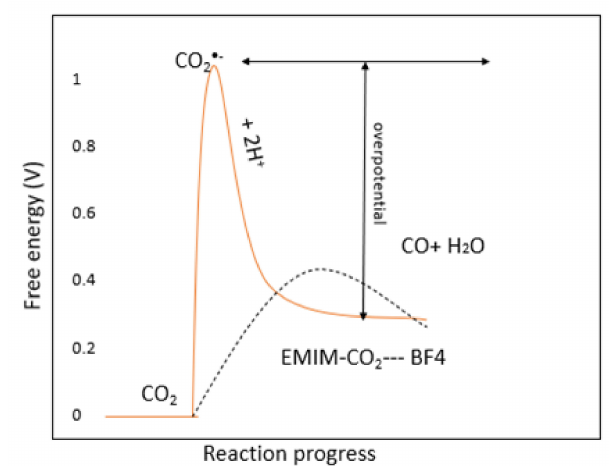
Figure 9. A schematic of how the free energy of the system changes during the reaction of CO 2 + 2H + + 2e − → CO + H 2 O in water or acetonitrile (solid line) or in the IL [Emim][BF 4 ] (dashed line) [45]. Sun et al. and Ramesha [85] studied the selectivity of the reaction towards CO, where they used Pb as the cathode and [Emim][Tf 2 N] as the electrolyte, and they found that the production of CO can be attributed to the interaction between CO 2 and the cation [Emim] + monolayer at the cathode surface. The results indicated that the CO 2 •− and [Emim] + adsorbed on the cathode surface could direct the CO 2 •− reaction toward forming CO rather than oxalate. They concluded that [Emim] + stabilized the CO 2 •− radical, which shifted the reaction in the direction of forming CO rather than oxalate, as shown in Figure 10. Hu et al. studied CO 2 reduction by using MoO 2 as the cathode and different imidazolium-based ILs as electrolytes at several temperatures and pressures [86]. The IL 1-butyl-3-methylimidazolium hexafluorophosphate [Bmim][PF 6 ] recorded the highest activity results at low temperatures. They demonstrated that the IL cations play the role of the co-catalyst in enhancing catalytic activity.